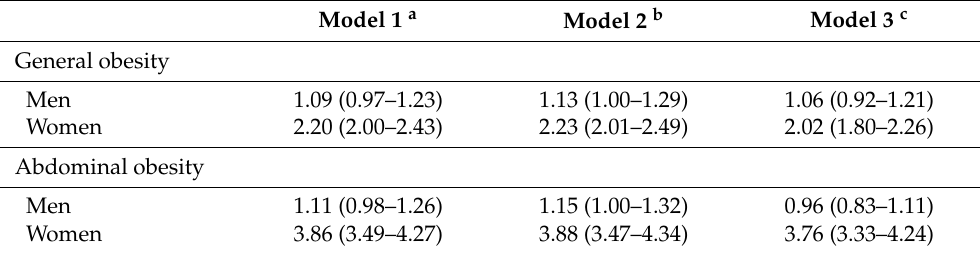
Table 4. Odds ratios of general and abdominal obesity in Know Your Heart study versus the seventh Tromsø Study with stepwise adjustments for socio-demographic characteristics, lifestyle characteristics and their interactions with the study-defining